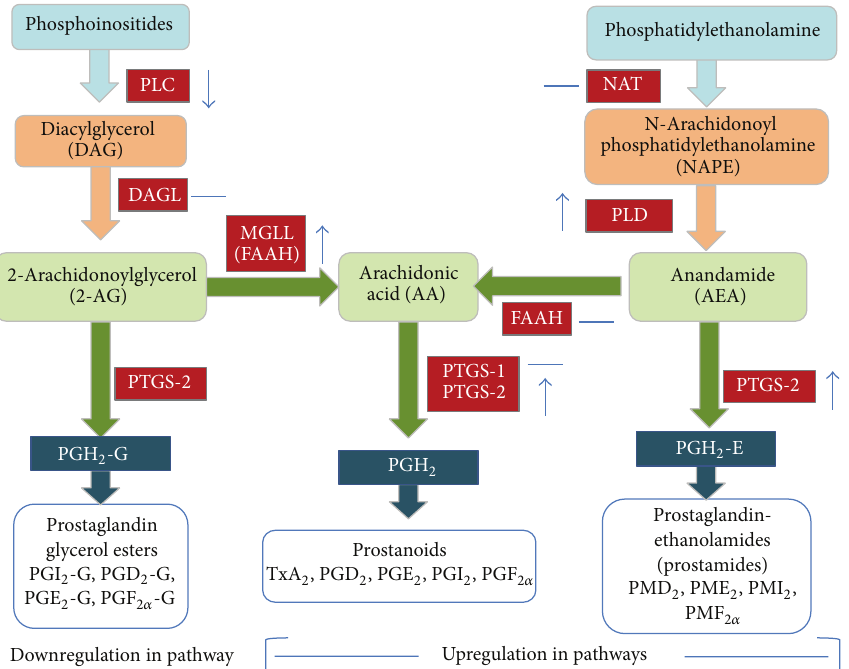
Figure 5: Proposed model of gestational related changes in gene expression of endocannabinoid system genes, as pregnancy progresses from mid to late gestation in rat